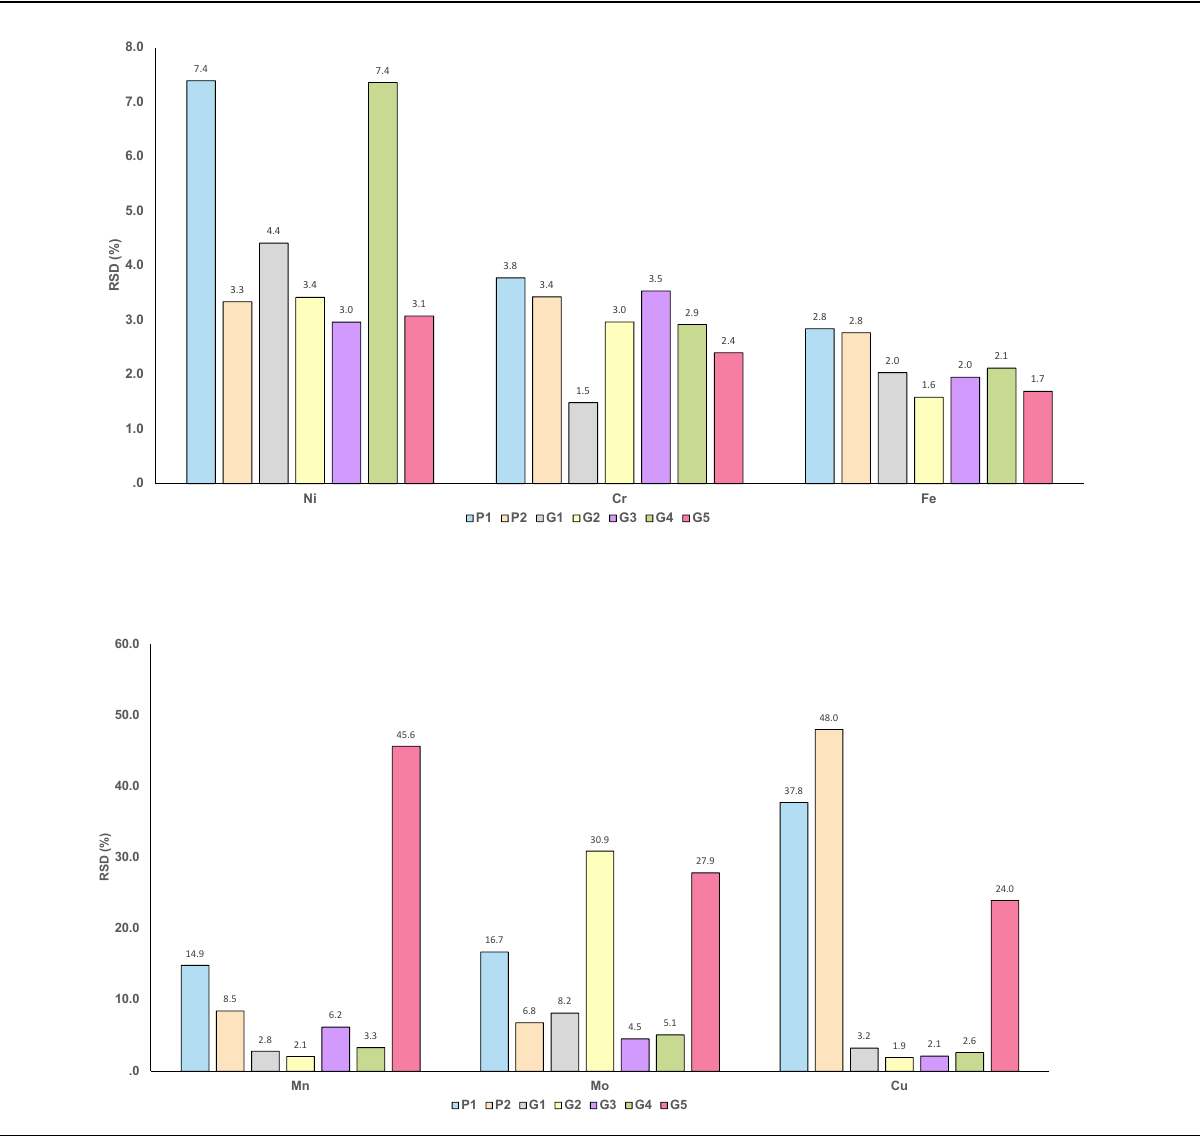
Figure 3. Comparisons of the relative standard deviations (RSD) for (a) Ni, Cr and Fe and (b) Mn, Mo and Cu across each brand of bracket (P1 to